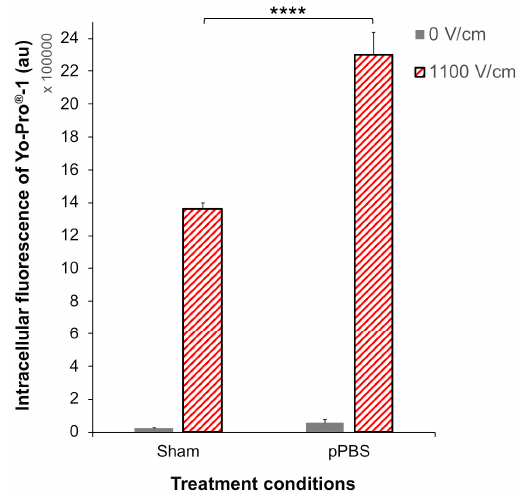
Figure A2. Enhanced electropermeabilisation of adherent DC-3F cells with pPBS treatment. Cells were pre-treated with pPBS for 10 min. and exposed to 8 pulses of 100 µs and 1100 V/cm at a 1 Hz repetition rate. The cell membrane permeabilisation was monitored by the fluorescence of the YO-PRO ® -1 iodide taken up by the cells. Data are presented as median values ± SD of independent triplicates. Statistical analysis used the One-way ANOVA followed by Bonferroni’s multiple comparison test. **** p < 0.0001.